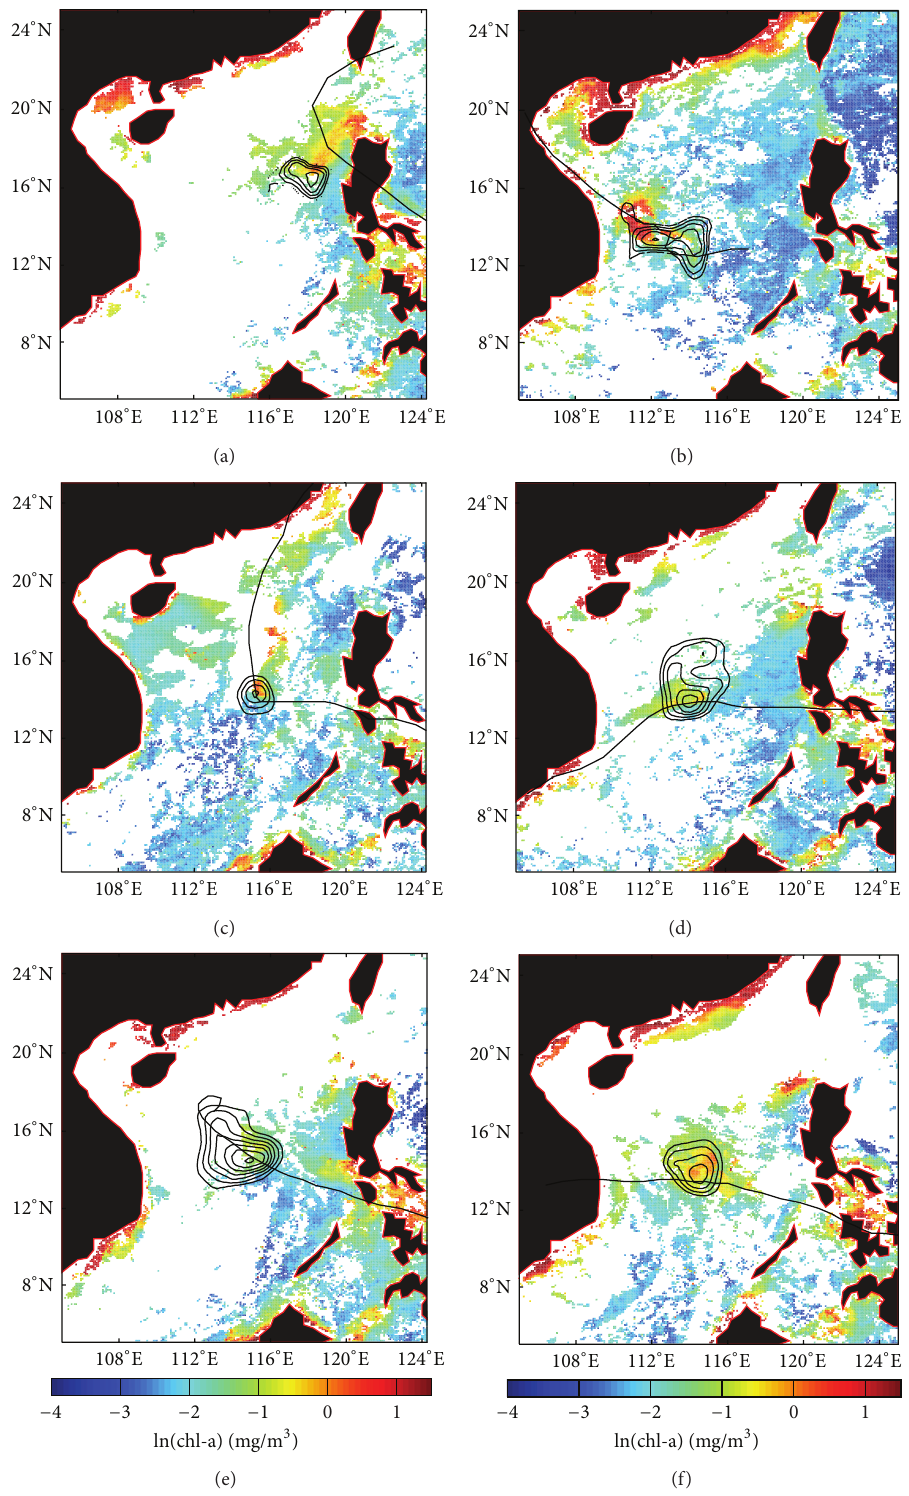
Figure 9: The chl-a blooms under the influence of typhoons in the CCE area. Colorbar is the natural logarithm value of chl-a concentration. The thick black solid lines in figures are typhoon tracks. The closed contours are the CCEs influenced by typhoons. (a) Typhoon Nanmadol in December 2004. chl-a concentration is from 2 December to 9 December. (b) Typhoon Kai-tak in November 2005, and chl-a concentration is from 1 November to 8 November. (c) Typhoon Chanchu in May 2006, and chl-a concentration is from 17 May to 24 May. (d) Typhoon Durian in December 2006, and chl-a concentration is from 3 December to 10 December. (e) Typhoon Utor in 2006, and chl-a concentration is from 11 December to 18 December. (f) Typhoon Lingling in 2001, and chl-a concentration is from November 9 to November